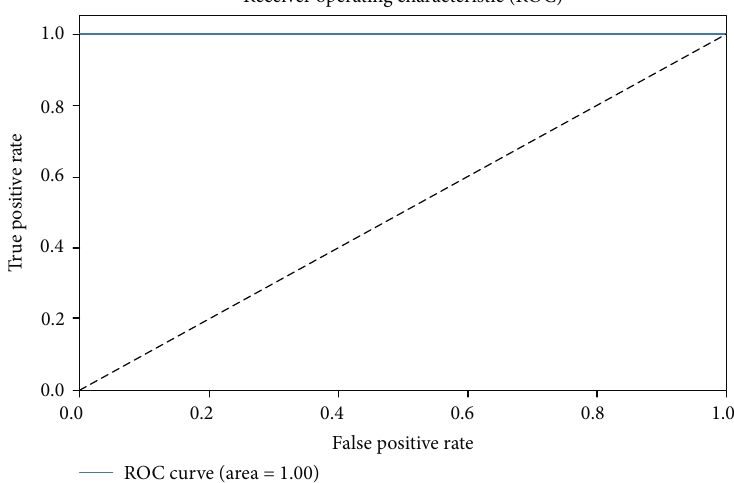
Figure 8: The ROC characteristics of